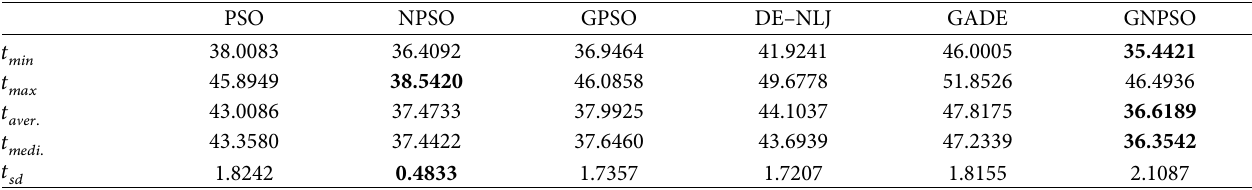
Table 18: Statistical results of computation time (sec) using different algorithms for Case 1: linear wing vibration system with single control